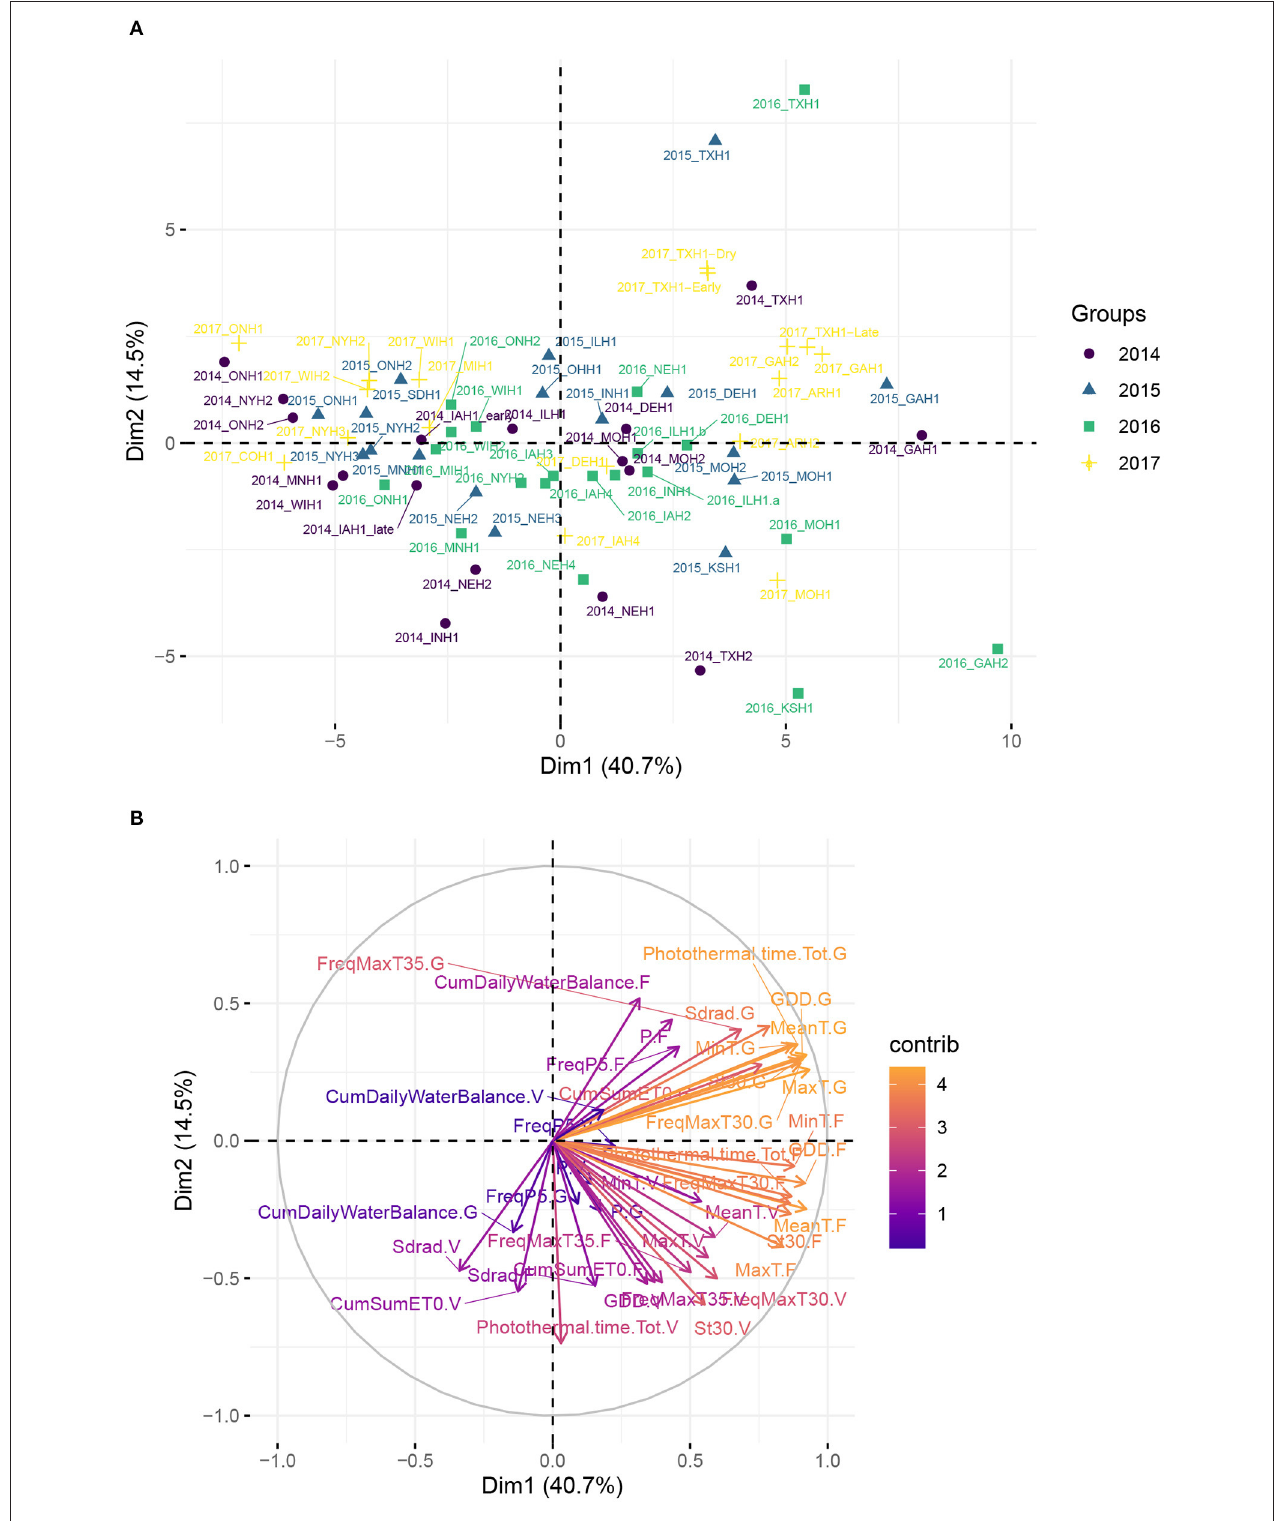
FIGURE 2 | Principal component analysis (PCA) plot of environmental data from the 71 environments, using the median flowering date as reference in each environment. (A) Maize trial experiments located in the US and in Canada used in analyses. Name of the locations and their geographical position are given in Supplementary Table 1 . (B) Correlation plot of the weather-based covariates used in the PCA.